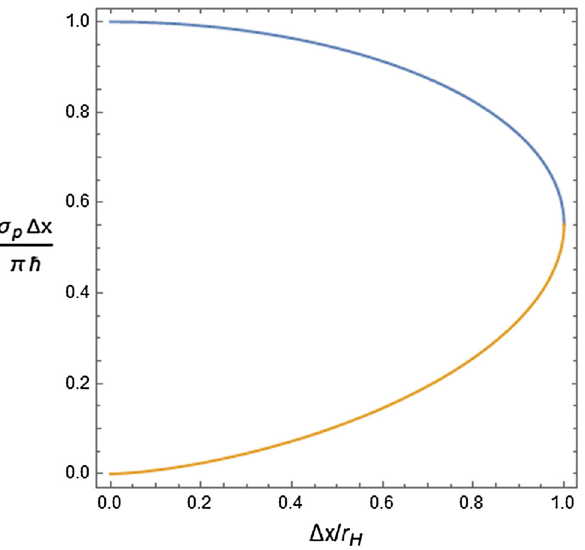
Fig. 3 The uncertainty relation (6) for the Friedmann cosmology in terms of the rescaled position uncertainty (cid:4) x / r H in units of π ¯ h . In these units the uncertainty approaches its minimum value of 0. The curve is passed through the two branches (blue and orange) clockwise from top to bottom. For reasons of comparison, we have used the same notation as in Fig.2 of [9], that is ˜ r ≡ (cid:4) x (see